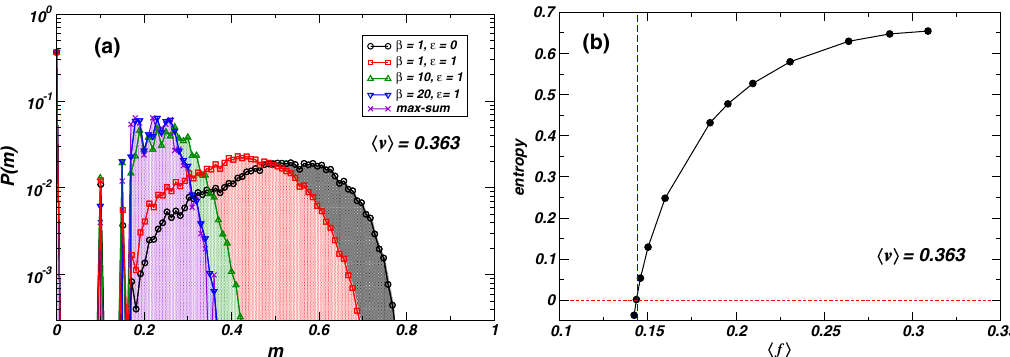
FIG. 13. (a) Distribution P ð m Þ of the probability m that a node got infected during the SIR process on random regular graphs of degree K ¼ 4 , q ¼ 0 . 1 , p ¼ 0 . 5 , h v i ¼ 0 . 6 , and different values of β and ϵ . (b) Entropy of immunization sets of density h v i ¼ 0 . 363 as a function of h f i (obtained by increasing β for ϵ ¼ 1 ).